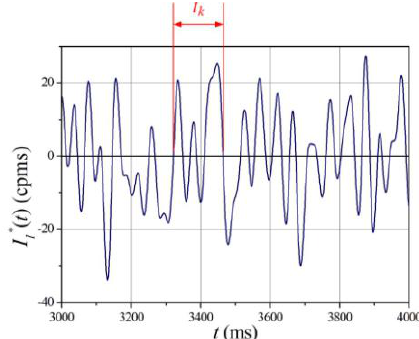
Fig. 6. Short part of filtered signal for analyzed experiment; t k - time duration.